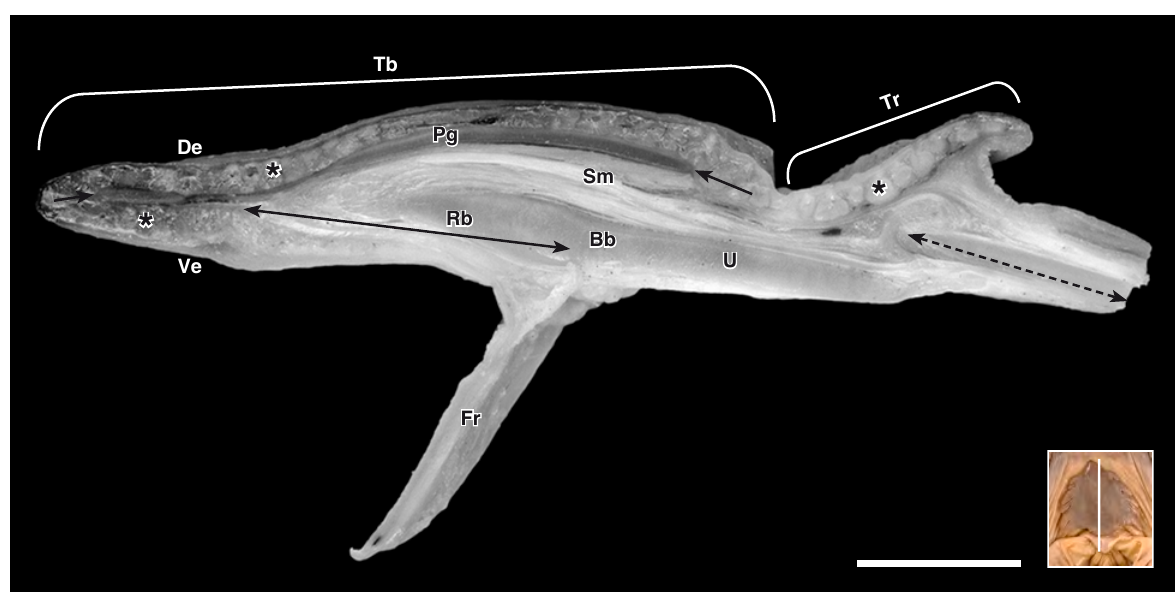
FIG. 1 Mid­sagittal section through the emu tongue illustrating the long rostral body (Tb), caudal root (Tr) and ventrally positioned frenulum (Fr). The core of the rostral tongue body is formed by the paraglossum (Pg, extremities indicated by the arrows) and the rostral projection of the basihyale (Rb). (The solid double­headed arrow indicates the actual extent of the Rb). Note the continuity between the rostral projection of the basihyale , the body of the basihyale (Bb) and the urohyale (U) in the caudal tongue body. Large, simple branched tubular mucus­secreting glands (*) are visible macroscopically as pear­shaped or round structures in the tongue body and root. Skeletal muscle fibres (Sm) attach to the ventral aspect of the paraglossum . Dorsal epithelium (De), ventral epithelium (Ve), cricoid cartilage (dotted double­headed arrow). Bar = 5 mm